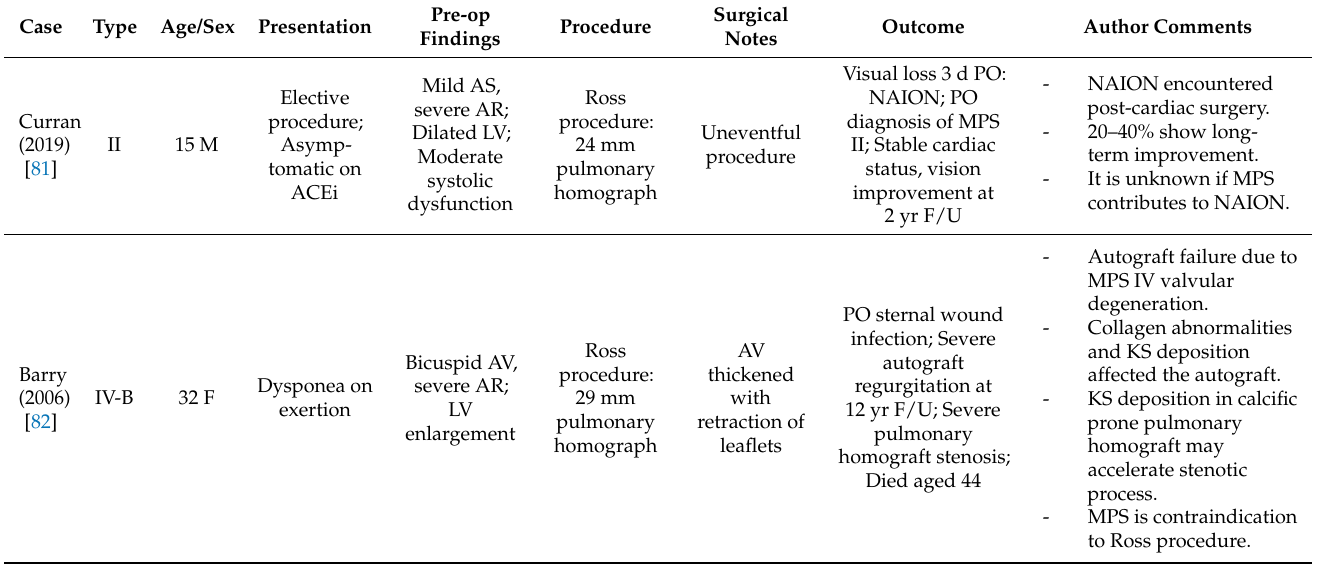
Table 3. Description of case reports of Ross procedures in patients with